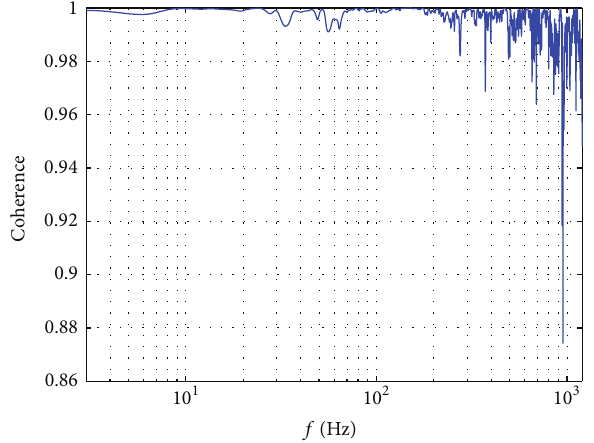
Figure 3: The frequency-domain coherence between magnetic noise signals of different receivers.